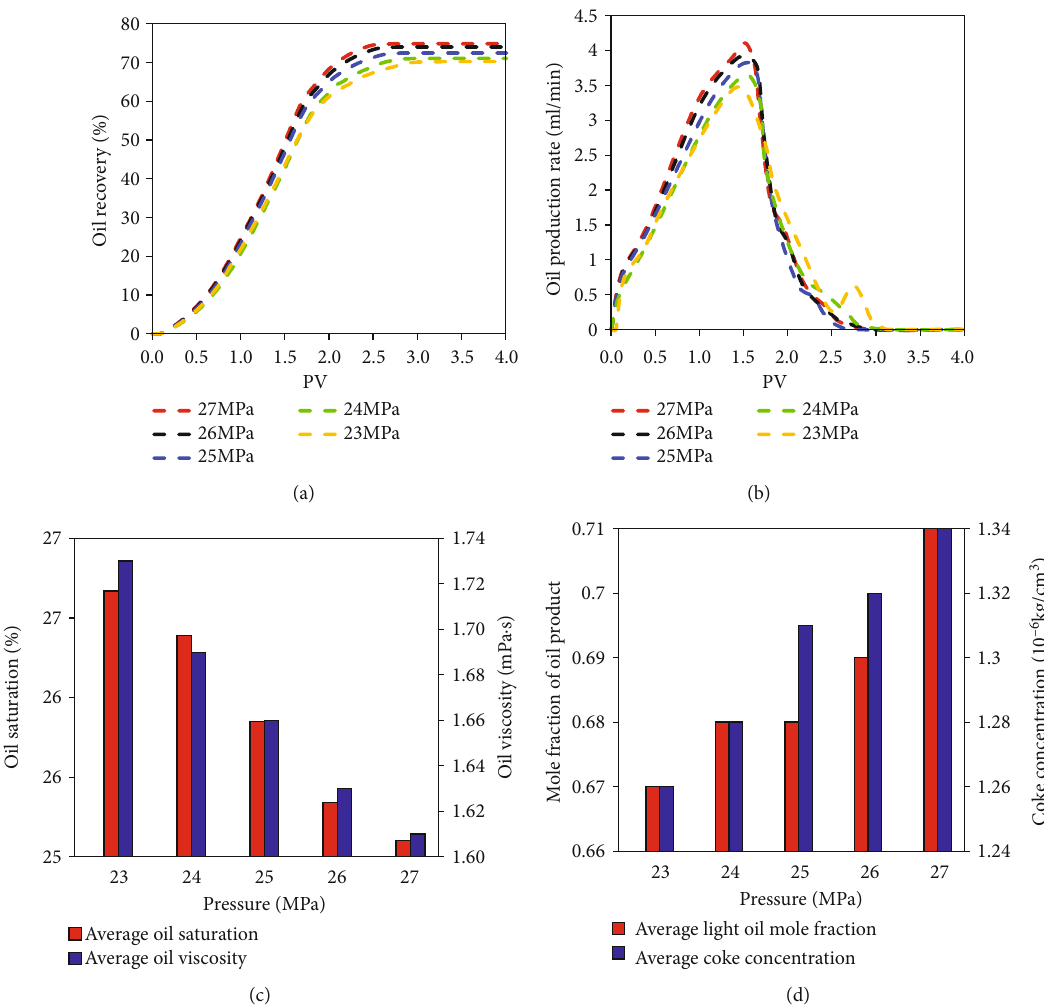
Figure 11: Comparison of SCW fl ooding at di ff erent pressures: (a) oil recovery, (b) oil production rate, (c) average oil saturation and oil viscosity, and (d) average light oil mole fraction and coke